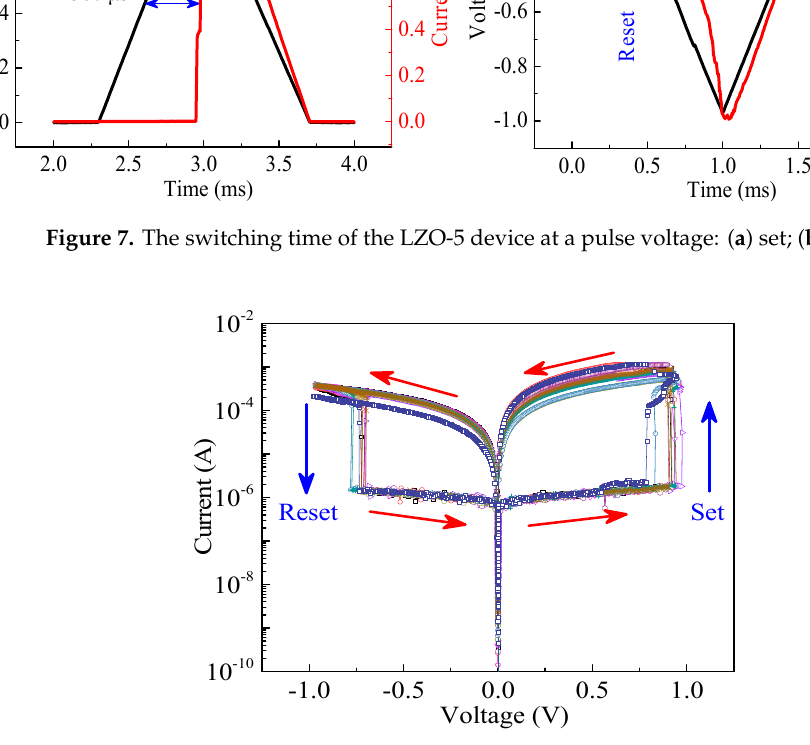
Figure 7. The switching time of the LZO-5 device at a pulse voltage: ( a ) set; ( b ) reset.